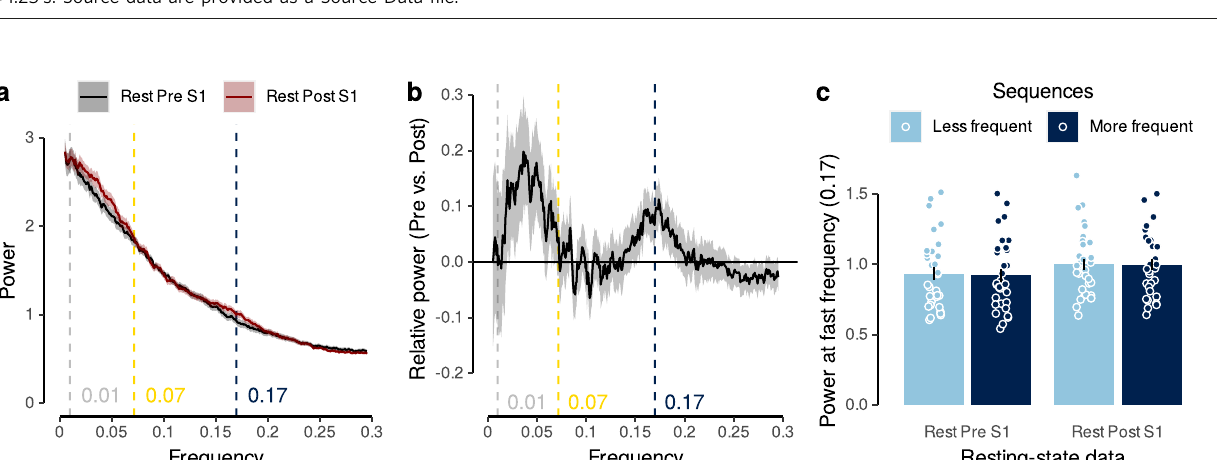
Fig. 5 Detecting sparse sequence events with lower SNR. a Mean standard deviation of classi fi er probabilities in rest and sequence data ( n = 32, t s ≥ 4.17, p s < 0.001, d s ≥ 0.74, two two-sided paired t -tests comparing rest and 2048 ms conditions against 32 ms condition, FDR-corrected). b Mean absolute regression slopes, as in (a) ( n = 32, t s ≥ 4.64, p s < 0.001, d s ≥ 0.82, two two-sided paired t -tests comparing rest and 2048 ms conditions against 32 ms condition, FDR-corrected). c Time courses of the regression slopes (signed values, not magnitudes) in rest and sequence data. Vertical lines indicate trial boundaries. d Normalized frequency spectra of regression slopes in rest and sequence data. Annotations indicate predicted frequencies based on Eq. (5). e Mean power of predicted frequencies in rest and sequence data, as in (a). Each dot represents data from one participant ( n = 32, t s ≥ 3.10, p s ≤ 0.002, two-sided paired t -tests, FDR-corrected). f Mean standard deviation of rest data including a varying number of SNR-adjusted sequence events (fast or slow). Dashed line indicates indifference from sequence-free rest ( n = 32, t s ≥ 2.22, p s ≤ 0.04, 30 two-sided one-sample t -tests against chance, FDR- corrected). g Base-20 log-transformed p values of t -tests comparing the standard deviation of probabilities in (f) with sequence-free rest. Dashed line indicates p = 0.05 ( N = 32, t s ≥ 2.22, p s ≤ 0.04, 30 two-sided one-sample t -tests against chance, FDR-corrected). h Frequency spectra of regression slopes in SNR-adjusted sequence-containing rest relative to sequence-free rest. Rectangles indicate predicted frequencies, as in (d). i Mean relative power of predicted frequencies in SNR-adjusted sequence-containing rest ( n = 32, t s ≥ 2.28, p s ≤ 0.03, two-sided t -tests against baseline, FDR-corrected). Shaded areas/error bars represent ±1 SEM. All statistics have been derived from data of n = 32 human participants who participated in one experiment. 1 TR = 1.25 s. Source data are provided as a Source Data fi le.